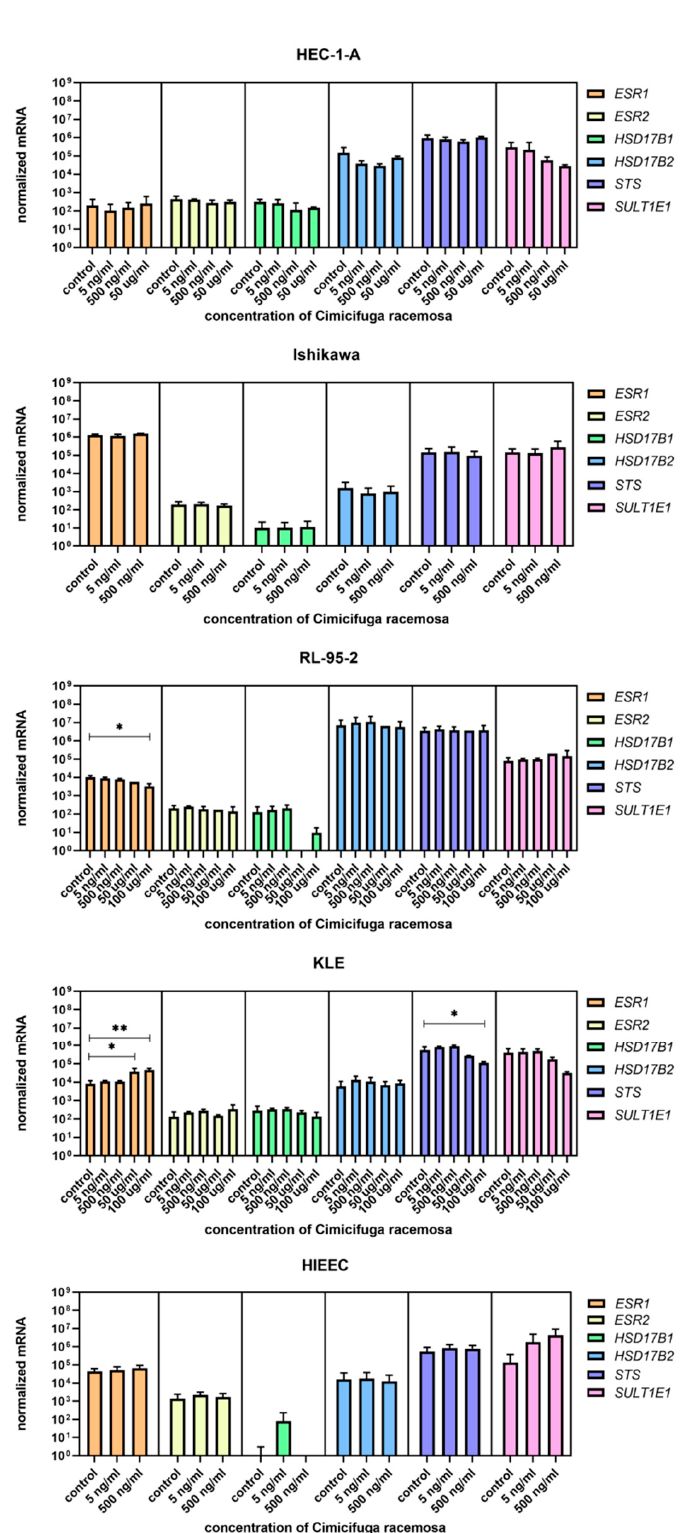
Figure 6. Normalized expression of genes encoding estrogen receptors and genes involved in estradiol biosynthesis and metabolism in endometrial cancer cell lines HEC-1-A, Ishikawa, RL-95-2, and KLE and control cell line HIEEC. At least three independent experiments were performed. Data are shown as mean ± SD. * p -value ≤ 0.05, ** p -value ≤ 0.01.